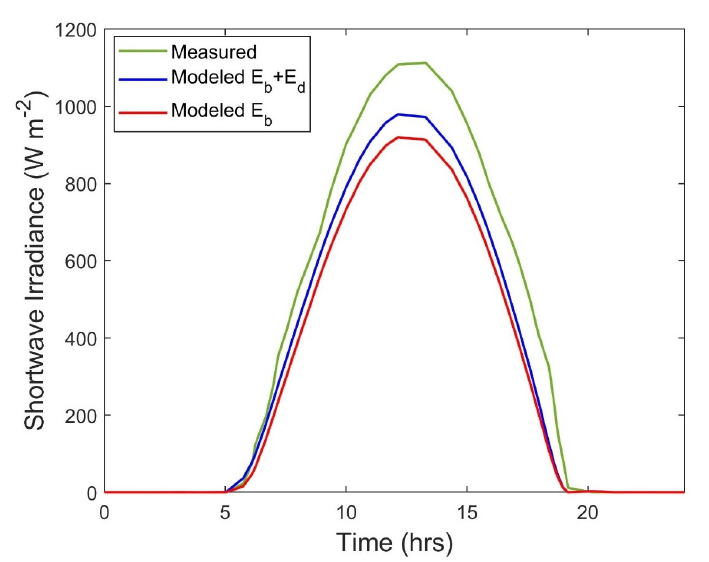
Figure 2. Modeled diurnal variation in shortwave irradiance on the Baltoro Glacier, values are compared to field data at the same location reported by Mihalcea et al. [66] on 24 July 2004. Shortwave irradiance is computed over the wavelength range of 0.3 µ m to 3 µ